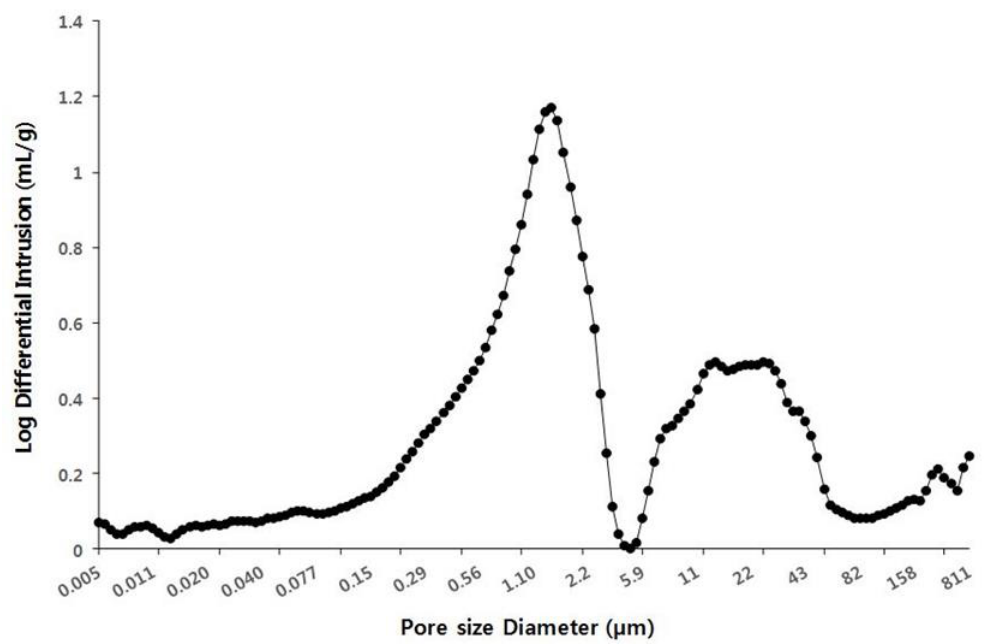
Figure 6. Porosity and density distribution on the cone scale surface.